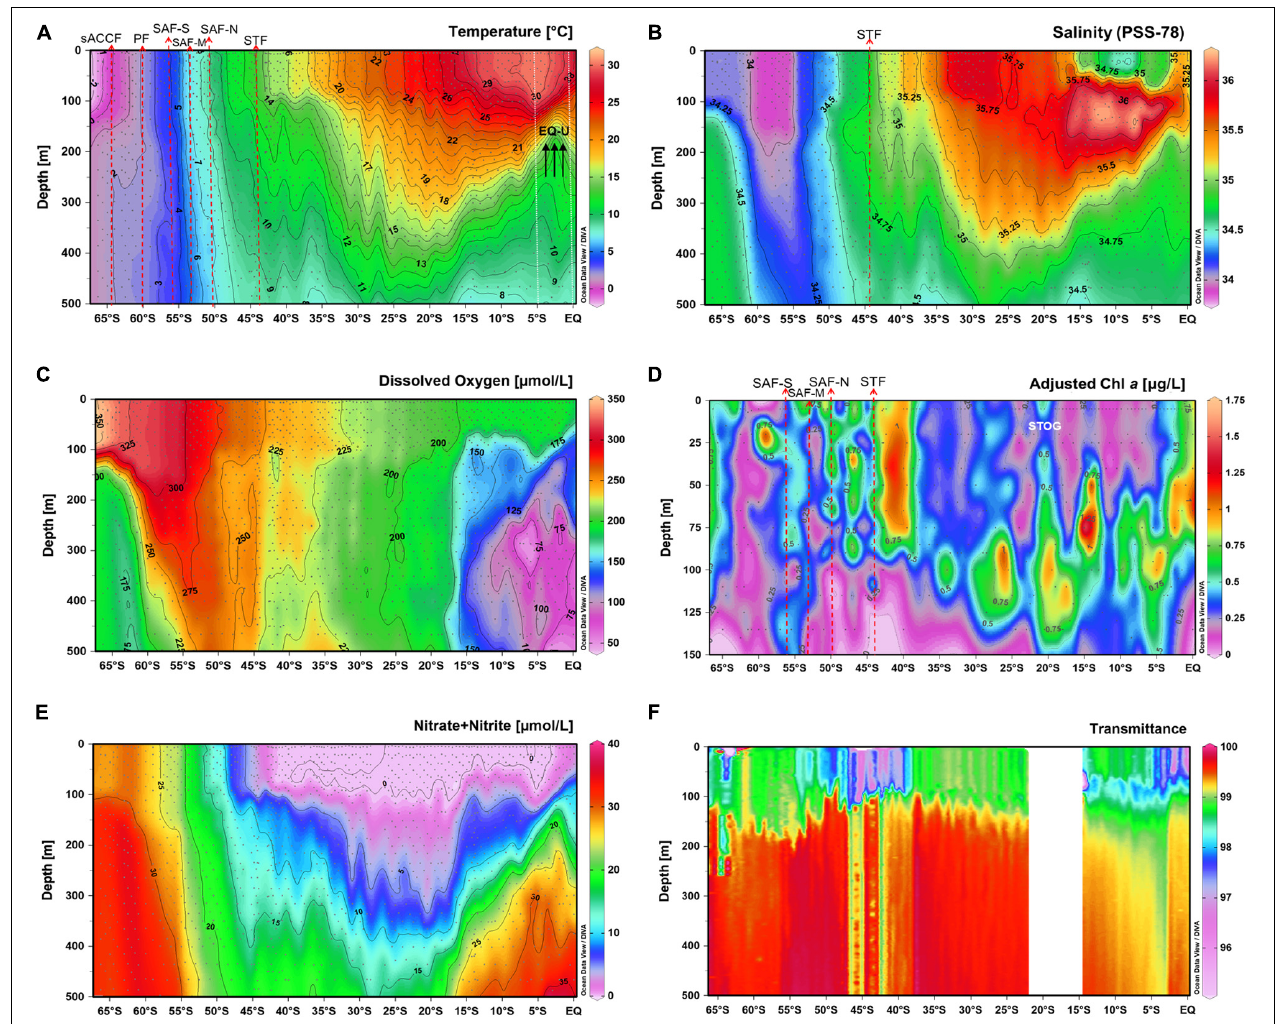
FIGURE 2 | Vertical distributions of (A) temperature, (B) salinity, (C) dissolved oxygen, (D) chlorophyll a , (E) nitrate + nitrite and (F) transmittance (%) within the top 500 m of the water column along the P15S sampling section (top 150 m for chlorophyll a ). Major oceanographic fronts are indicated by red dashed arrows, white dotted lines indicate approximate boundaries for subtropical gyre and equatorial upwelling zones. Front acronyms are as detailed in Figure 1